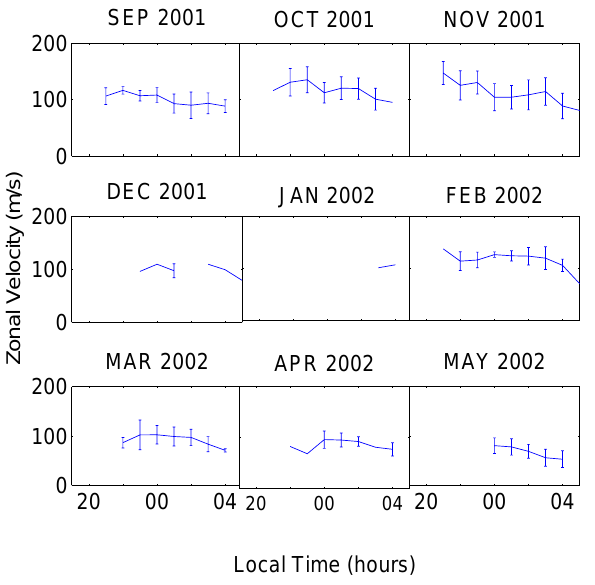
Fig. 7. Monthly means of hourly EPB drift velocity. Error bars in- dicate standard deviations including measurement and geophysical variability; lack of an error bar indicates fewer than three data.